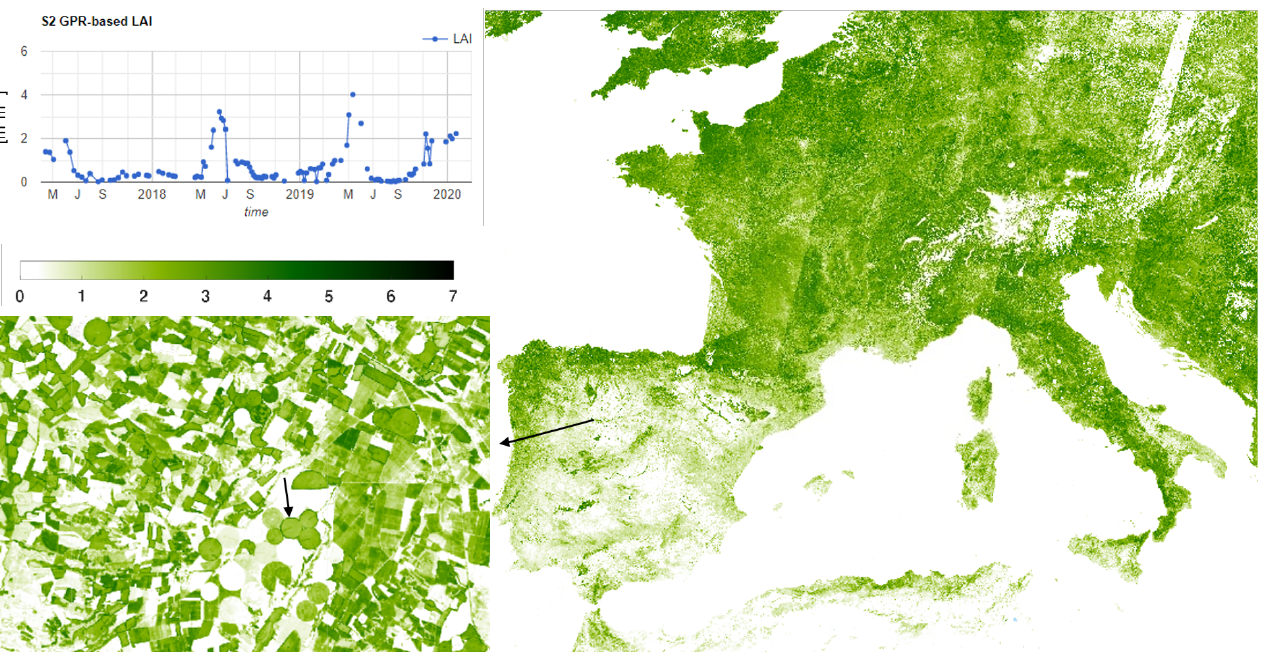
Figure 4. Big Scale LAI G Mosaic over Europe with 1 July to 15 July 2019 time span using maximum value